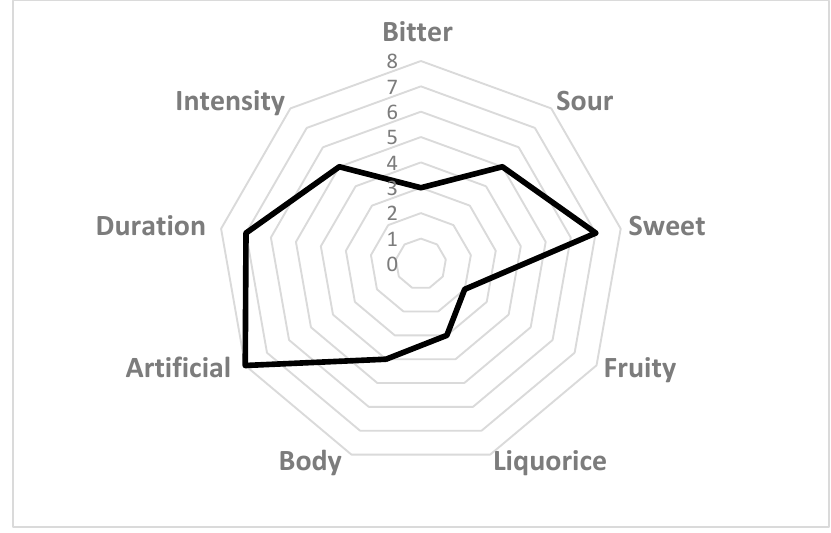
Figure 2. Example of spider graph.